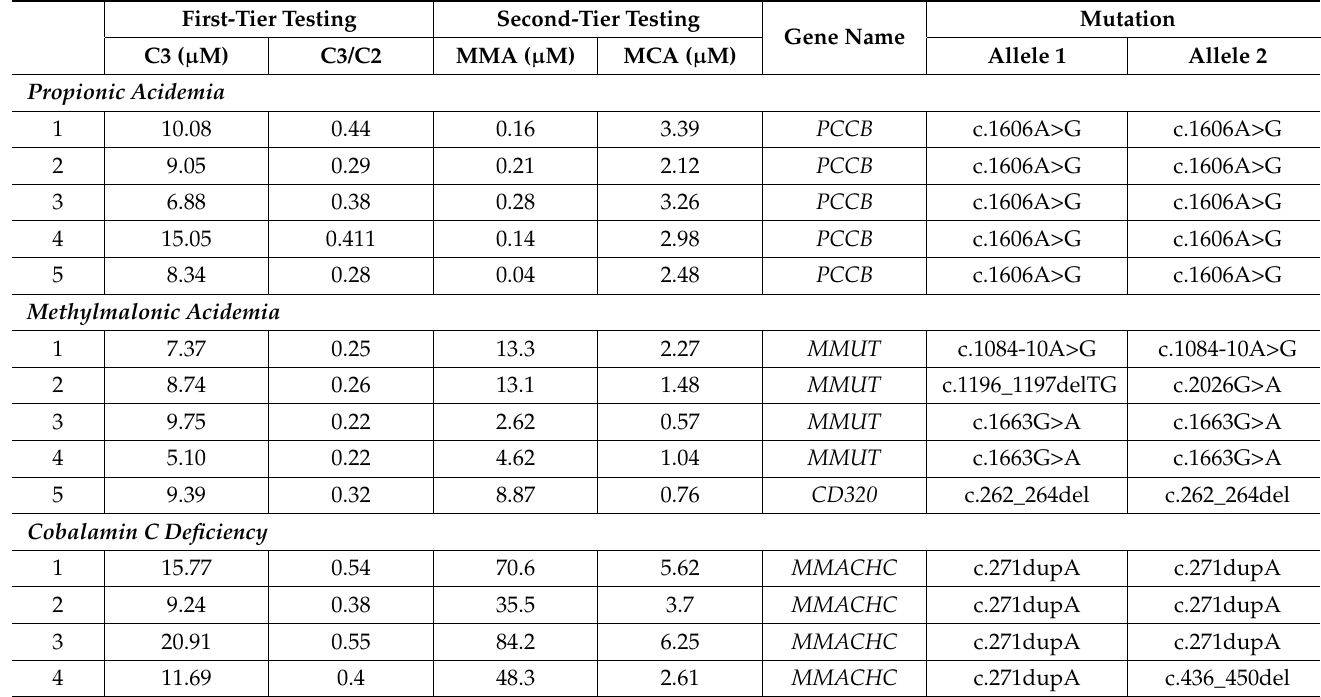
Table 2. Inborn errors of metabolism found on propionylcarnitine (C3)-positive newborn screens in Wisconsin from 2013 to